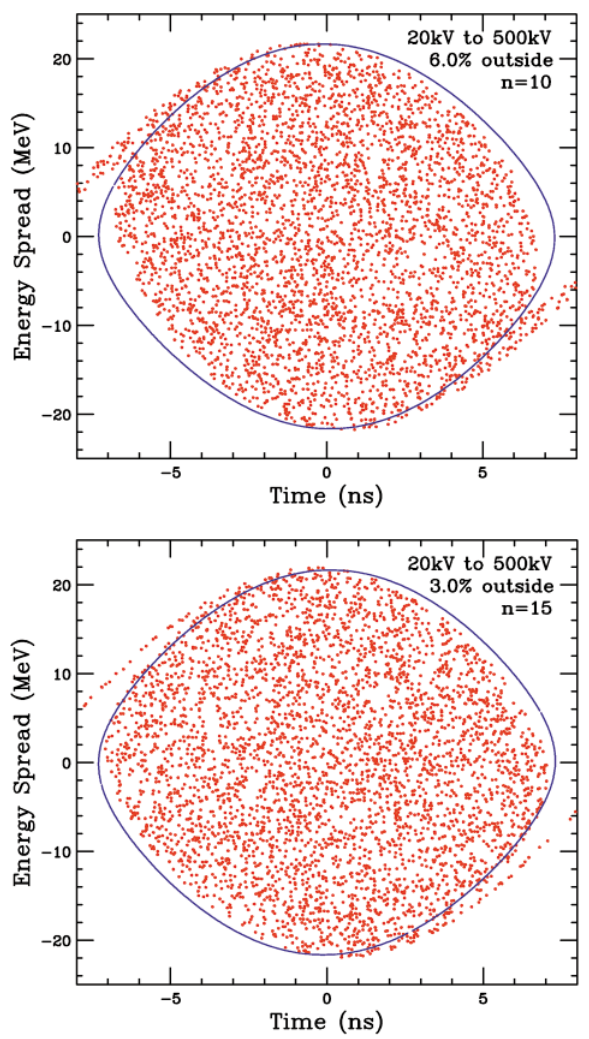
FIG. 13. (Color) Adiabatic capture starting from V 1 (cid:1) 20 kV to V 2 (cid:1) 500 kV with adiabaticity n (cid:1) 10 in the top plot and n (cid:1) 15 in the bottom plot. The solid blue curve in each plot represents the boundary of the bunch of 0.4544 eV s (initial area) matched to the rf voltage of V 2 . Particles outside the curve may be lost eventually. The loss is 6.0% for n (cid:1) 10 and reduces to 3.0% at n (cid:1) 15